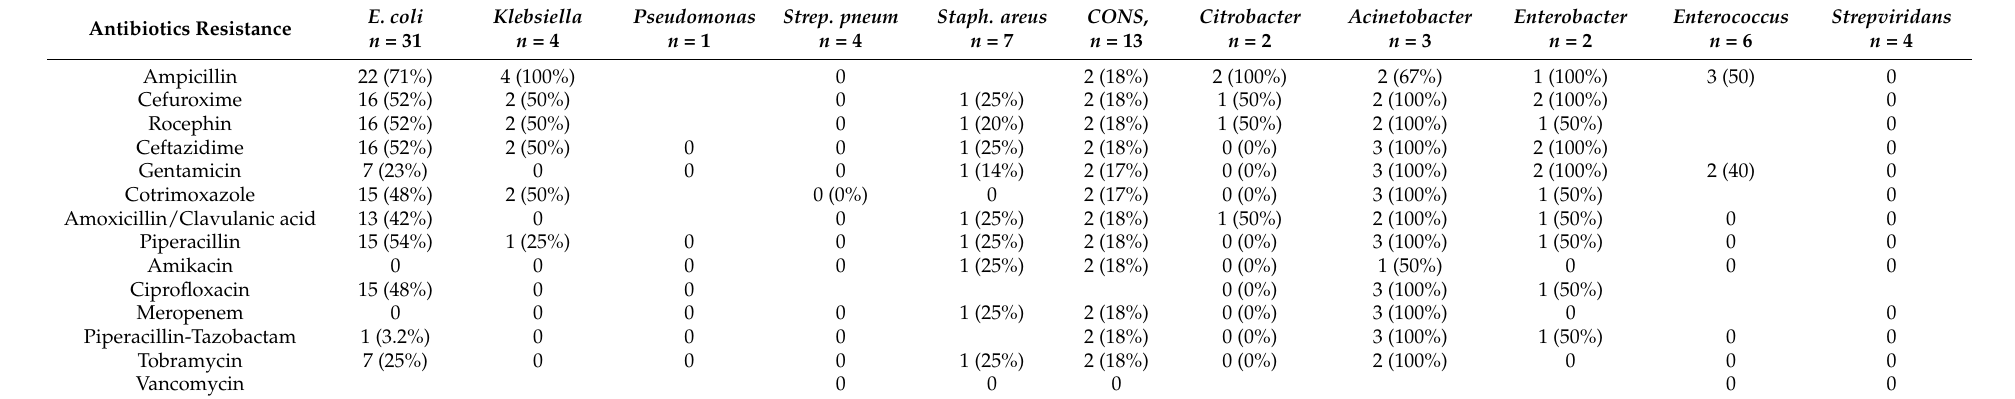
Table 3. Bacterial resistances of germs against specific